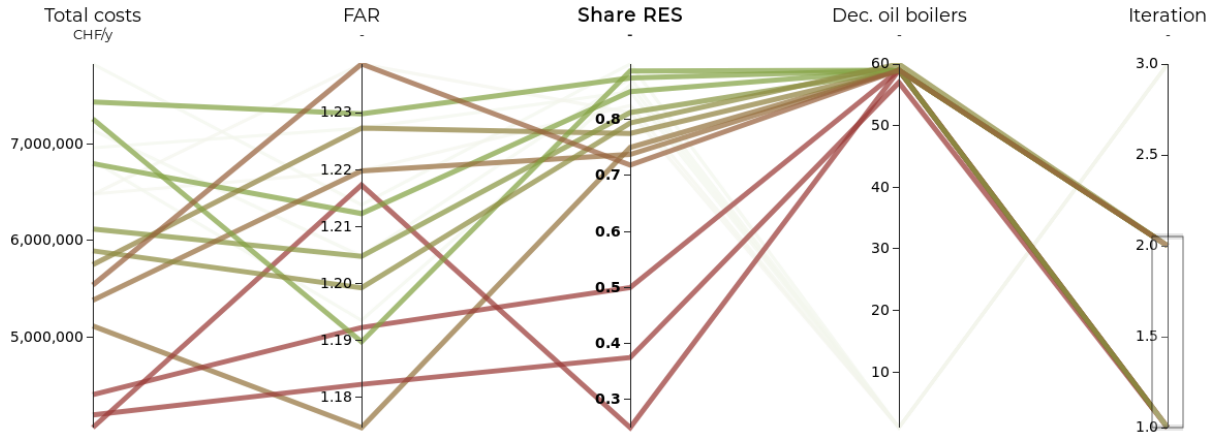
Figure 4. Parallel coordinate plot of solutions created via interactive optimization in URB io and stored via the proposed data model and the CityGML Scenario ADE (solutions are colored according to share of